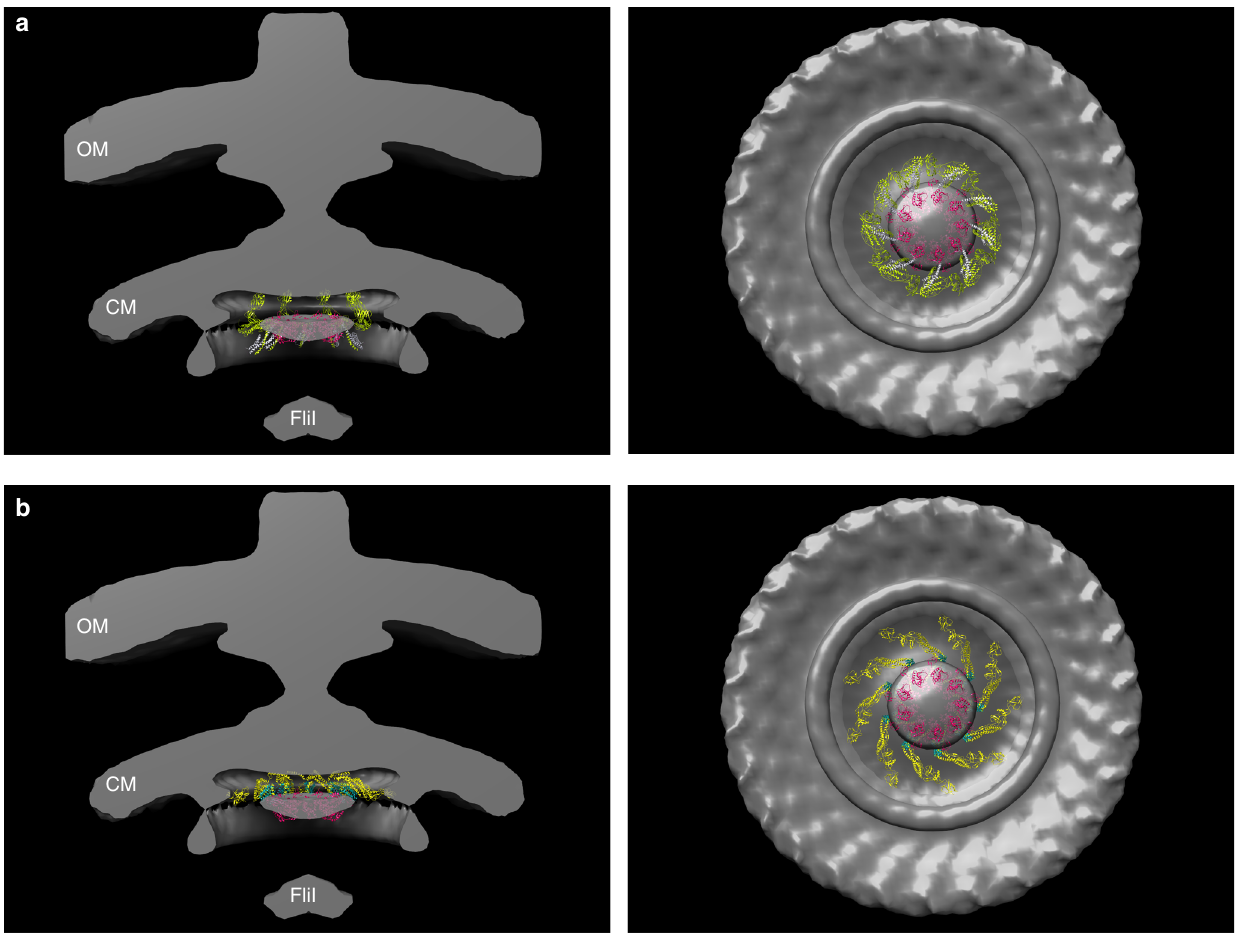
Fig. 6 Fitting of the FlhA C ternary complexes into the cryoEM density map of the fl agellum base body 44 . The nonameric oligomeric structure of FlhA C was generated using the structure of the homologous MxiA protein 28 . The ternary structures obtained in this work were then used to model the complete oligomeric nonameric ring of FlhA C bound to nine molecules of a FliT − FliD and b FliS − FliC. Non-cooperative binding of the chaperone – substrate molecules on FlhA C is assumed. The full-length FliD (5H5V) and FliC (PDB ID 3A5X) structures were used. FliI is the hexameric fl agellar ATPase. CM cytoplasmic membrane; OM outer membrane. Side views of half-cut sections and bottom views are shown. The colors of the FlhA C -chaperone – substrate complexes are as in Figs. 2 and